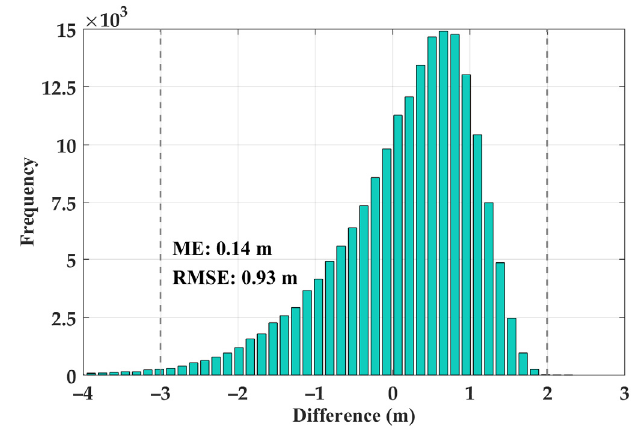
Figure 9. Histograms of the DTM difference ( DTM P-band minus DTM LiDAR ).